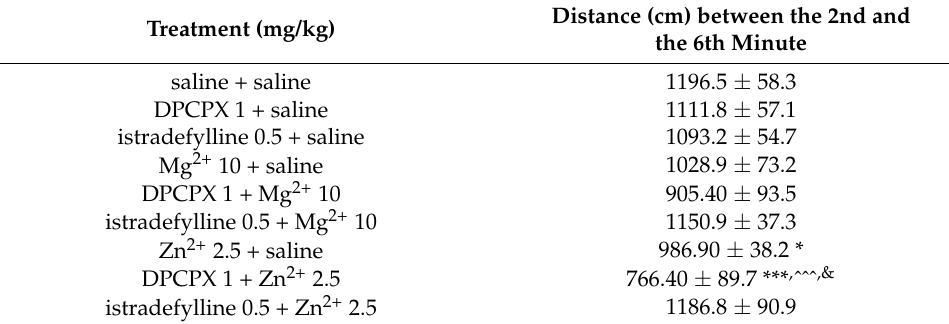
Table 1. Effect of treatments on mice spontaneous